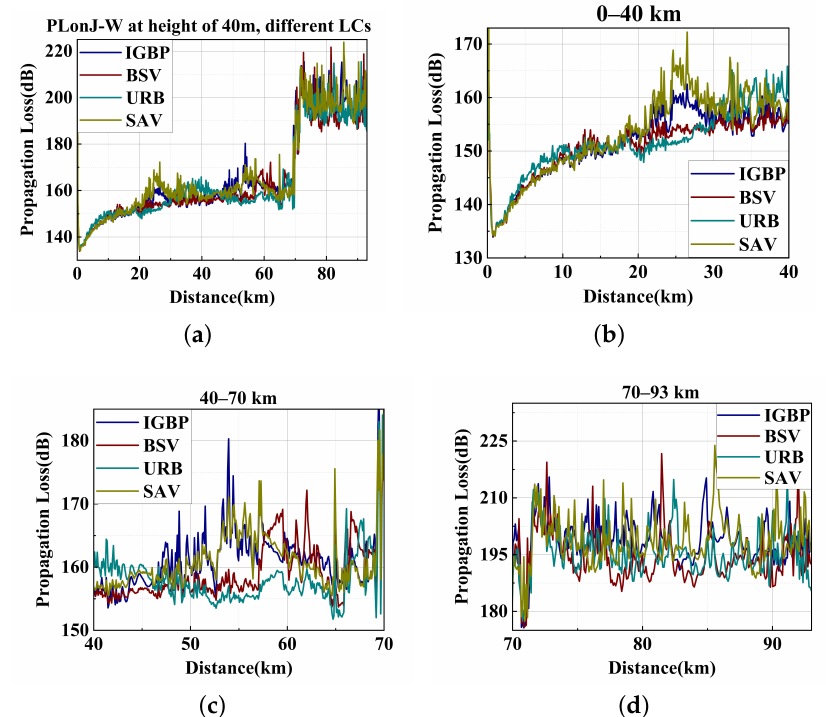
Figure 26. The propagation loss using the improved TWPE at a height of 40 m using different land covers, on Jiaxing–Wuxi. ( a ) PL on J–W at different LCs at an antenna height of 40 m. ( b ) PL on J–W at a range of 0–40 km at different LCs. ( c ) PL on J–W at a range of 40–70 km at different LCs. ( d ) PL on J–W at a range of 70–93 km at different